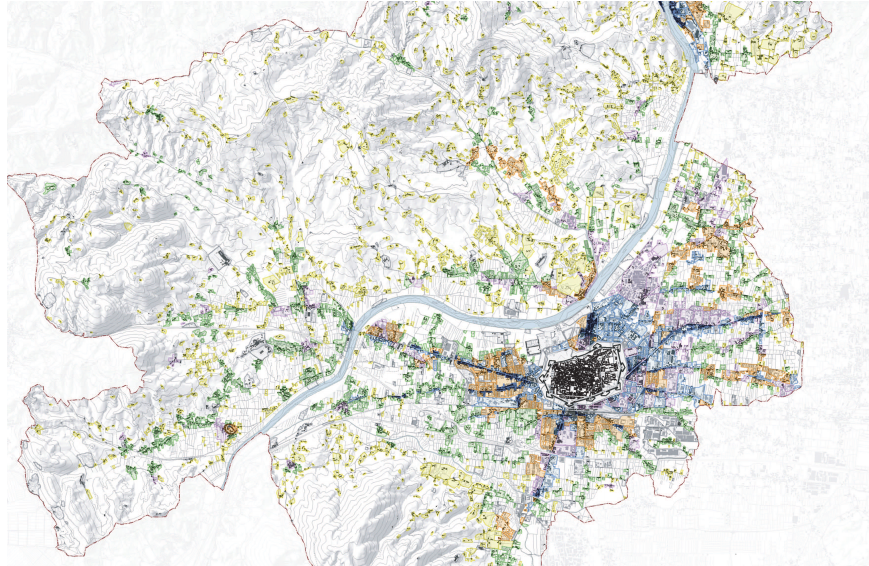
Figure 1. Urban development and the urban-rural relationship in the case of the Structural plan of Lucca, Italy. The map represents the morphological and figurative characterization of the urban fabric in the city of Lucca. In particular, it shows the development of the city toward the outside, by highlighting how the relation between the open (agricultural land) and the built environment (city) changes through the time (darker for historical settlements, lighter for newer ones; Source: Author’s Archive from the Research Project “Analysis of soil consumption in the city of Lucca”).